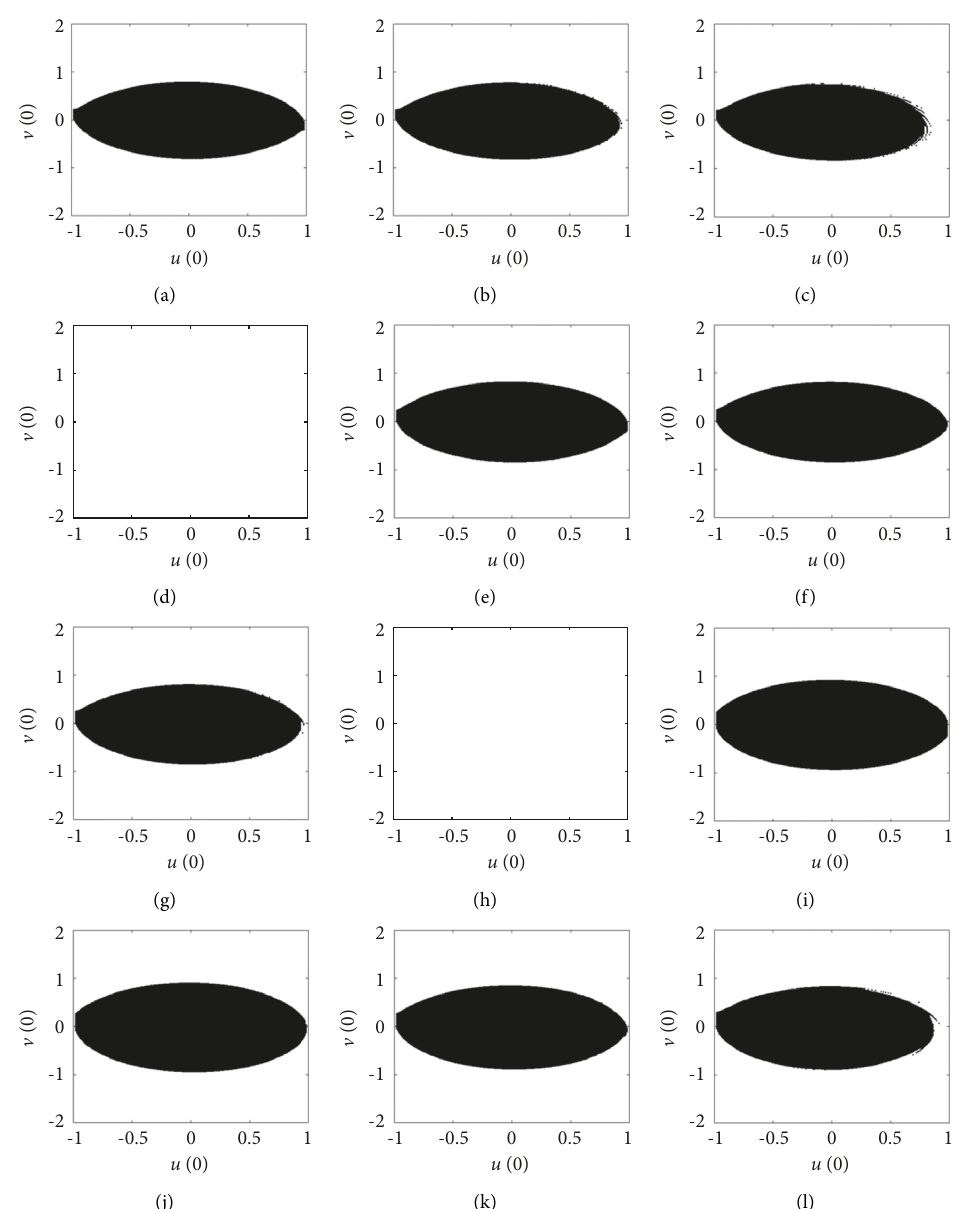
Figure 12: Evolution of safe basins of system (2) with the variation of ω and f � 0 . 35. (d) ω � 0 . 9, f (c) ω � 0 . 9, f 0 � 0 . 21. (j) ω � 1 . 2, f ω � 1 . 2, f 0